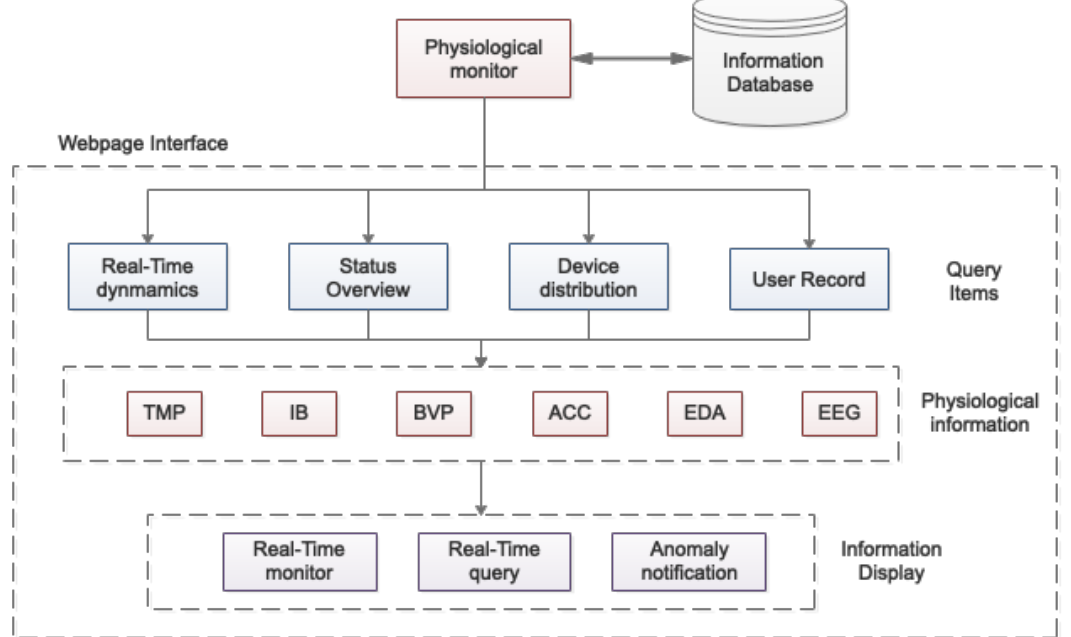
Figure 5. The reporting monitor subsystem’s work